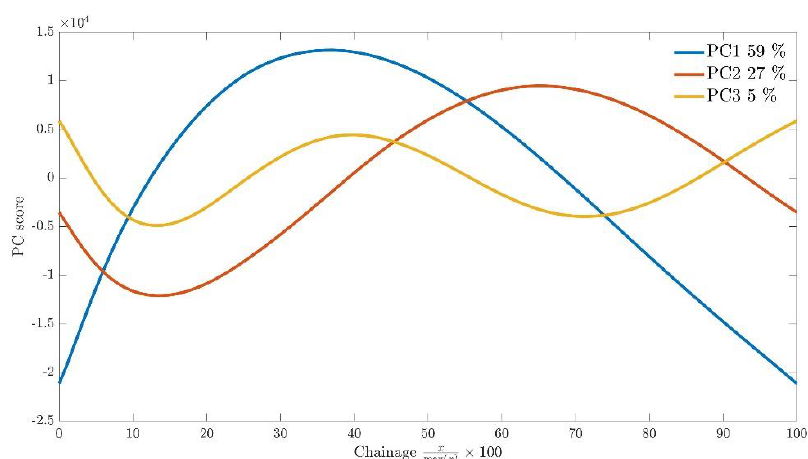
Figure 8. Cross-shore eigenvectors for the first three PCs. The percentage shown in the legend indicates the percentage of variability explained by each PC.